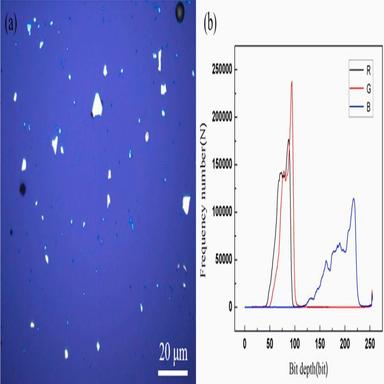
Optical image and its corresponding color histogram. (a) One of 50 optical images under unsaturated light intensity, (b) RGB color histogram.